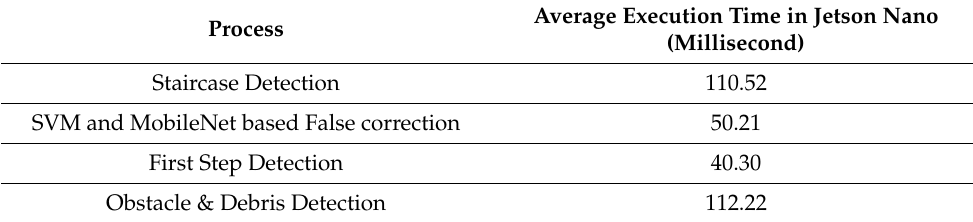
Table 4. Computation Time of Each Module.